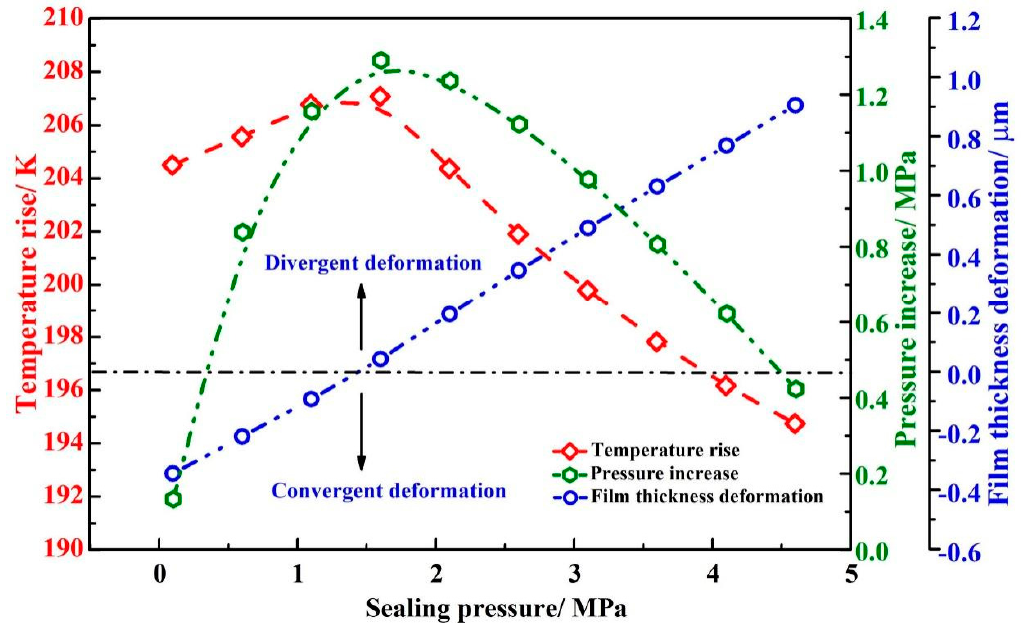
Figure 6. Variations of the pressure increase, temperature rise, and film thickness deformation with respect to the sealing pressure. ( P out = 0.1 MPa, T in = 200 K, T out = 350 K, n = 50,000 rpm, h 0 = 3 μ m).